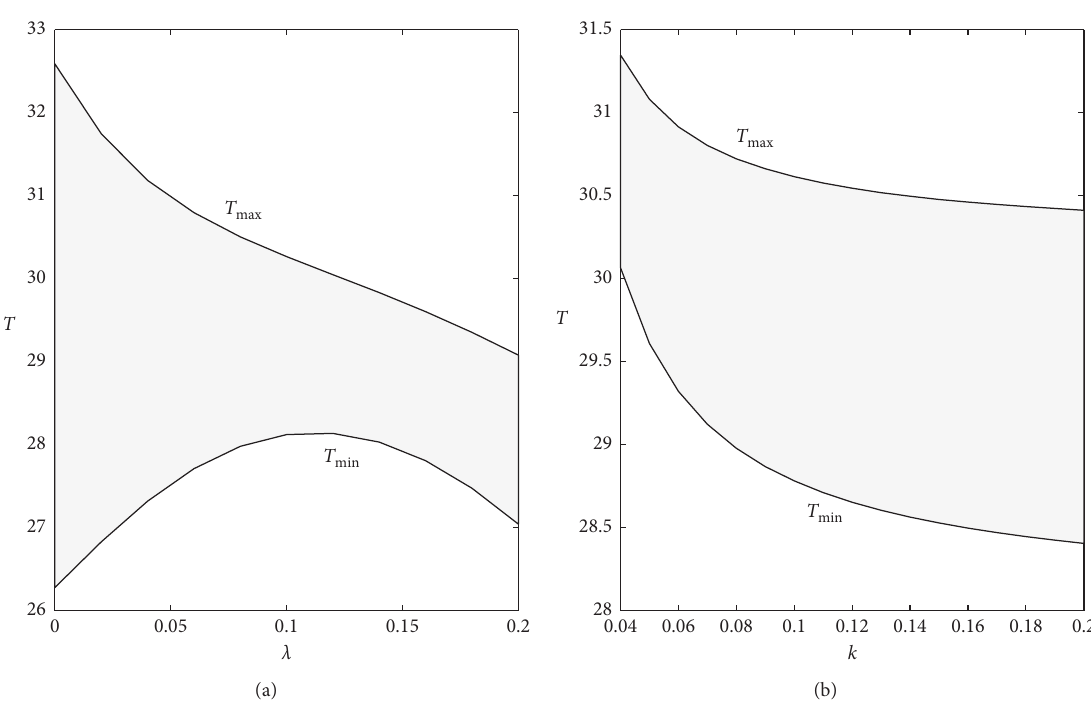
and φ on the profit difference Δ π M and Δ π S 1 2